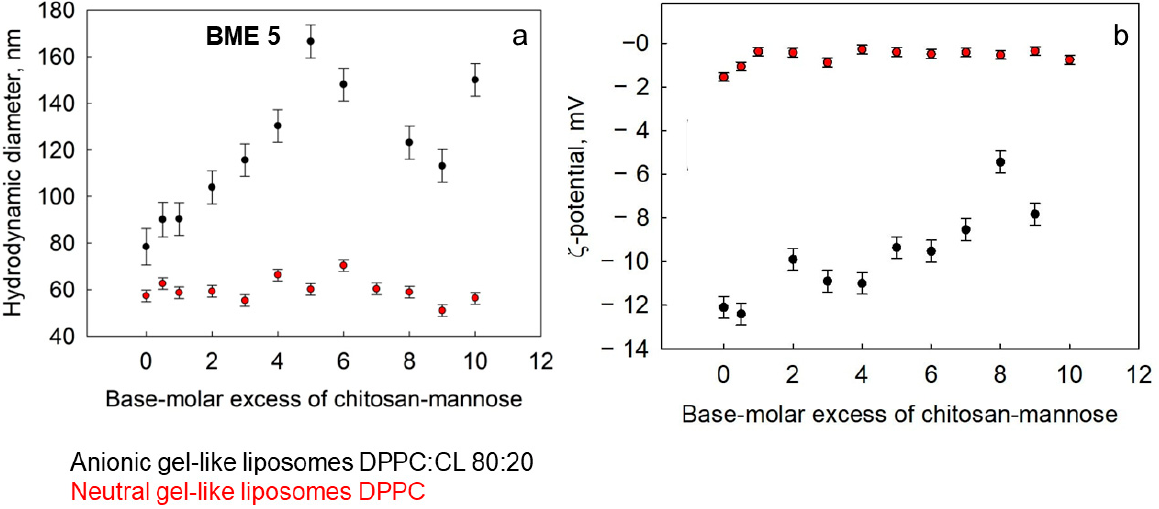
Figure 3. Dependance of main physicochemical properties of liposomal complex with ChitMan: DPPC: CL 80:20 liposomes (black) and DPPC liposomes (red): Dh, nm ( a ) and ζ -potential, mV ( b ). SD, n = 3. 0.02 M Na-phosphate buffer solution, pH 7.4, 22 ° С .